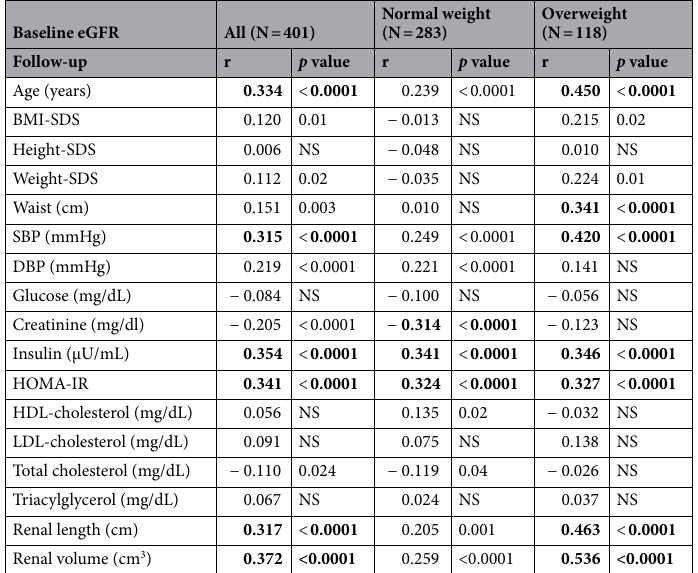
Table 2. Pearson correlation analyses of eGFR at baseline with selected variables at follow-up. BMI body mass index, SBP systolic blood pressure, DBP diastolic blood pressure, eGFR estimated glomerular filtration rate, HOMA-IR homeostatic model assessment of insulin resistance, NS non-significant. Moderate associations (Pearson’s r > 0.3) are shown in